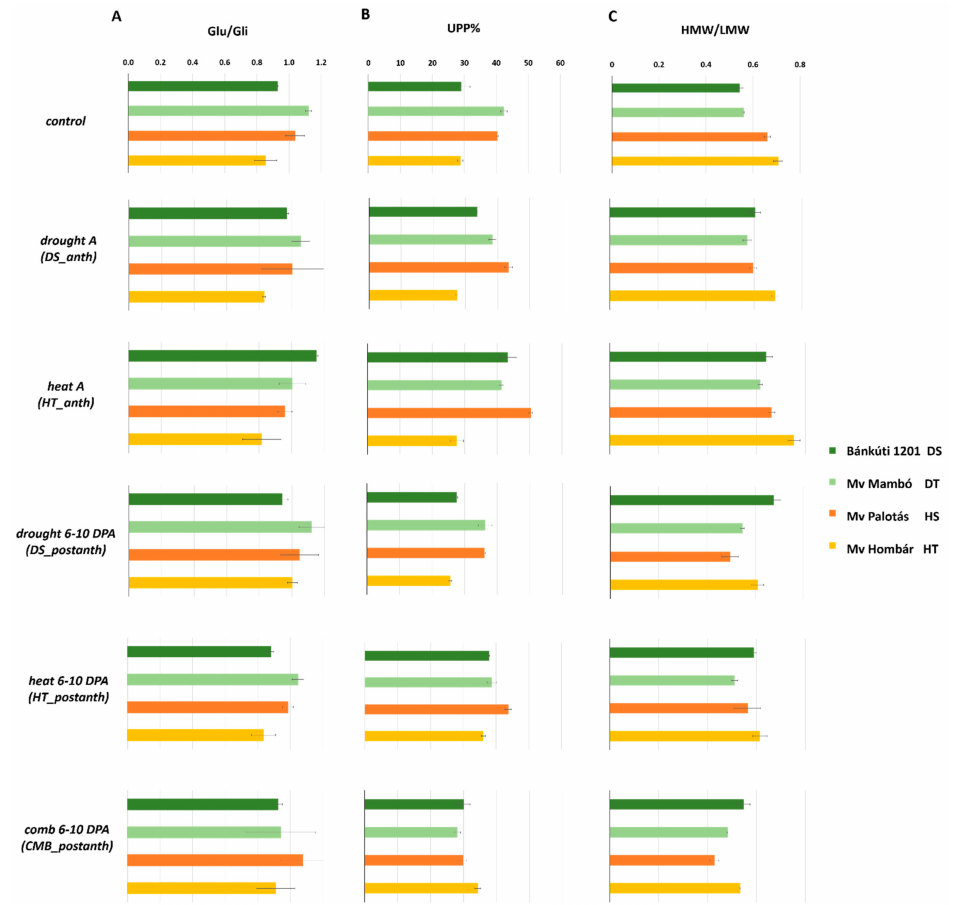
Figure 3. The alteration of Glu/Gli ( A ) and UPP% ( B ), as well as, HMW/LMW GS ratio ( C ) caused bydifferent abiotic treatments. UPP%—unextractable polymeric protein percentage; Glu/Gli— glutenin/gliadin ratio; HMW/LMW—high molecular weight glutenin/low molecular weight glutenin ratio. DS_anth : drought stress at anthesis; HT_anth : high temperature at anthesis; CMB_anth : combined stress at anthesis; DS_postanth : drought stress at post-anthesis; HT_postanth : high tempera- ture at post-anthesis; CMB_postanth : combined stress at